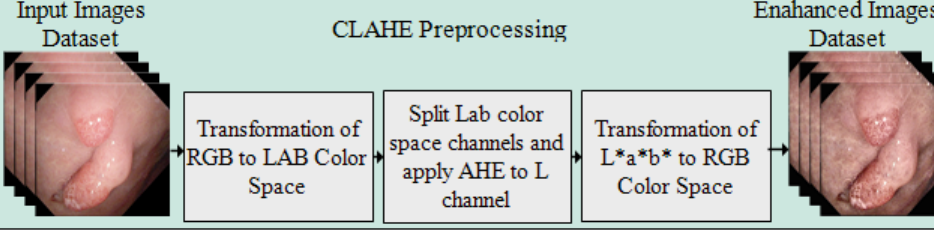
Figure 2. Flow diagram of CLAHE preprocessing method. (a) Original frames and (b) preprocessed frames.